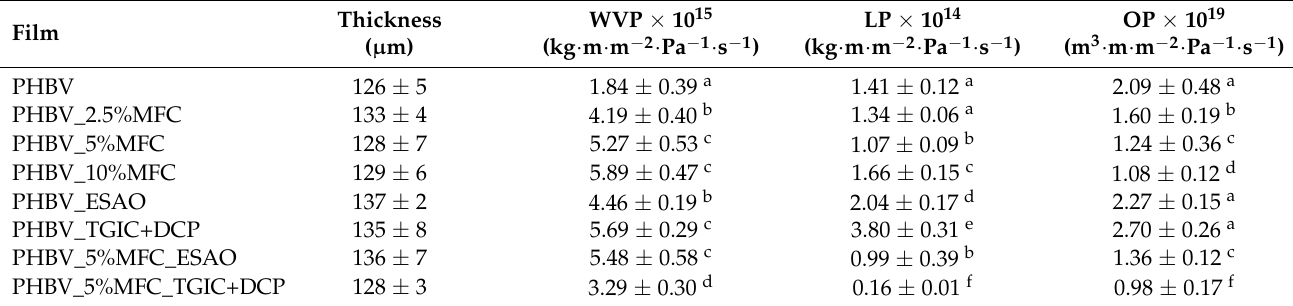
Table 6. Barrier properties of the films of poly(3-hydroxybutyrate- co -3-hydroxyvalerate) (PHBV) with microfibrillated cellulose (MFC) and compatibilized with epoxy-based styrene-acrylic oligomer (ESAO) and with triglycidyl isocyanurate (TGIC) and dicumyl peroxide